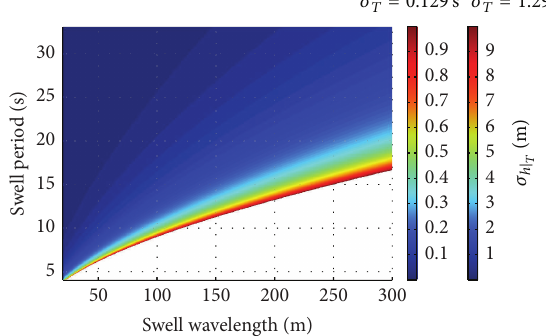
Figure7:Uncertaintyintheestimatedwaterdepthduetothatinthe swell period in the considered admissible (𝐿, 𝑇) area for 𝜎 𝑇 = 0.129s and 𝜎 𝑇 =